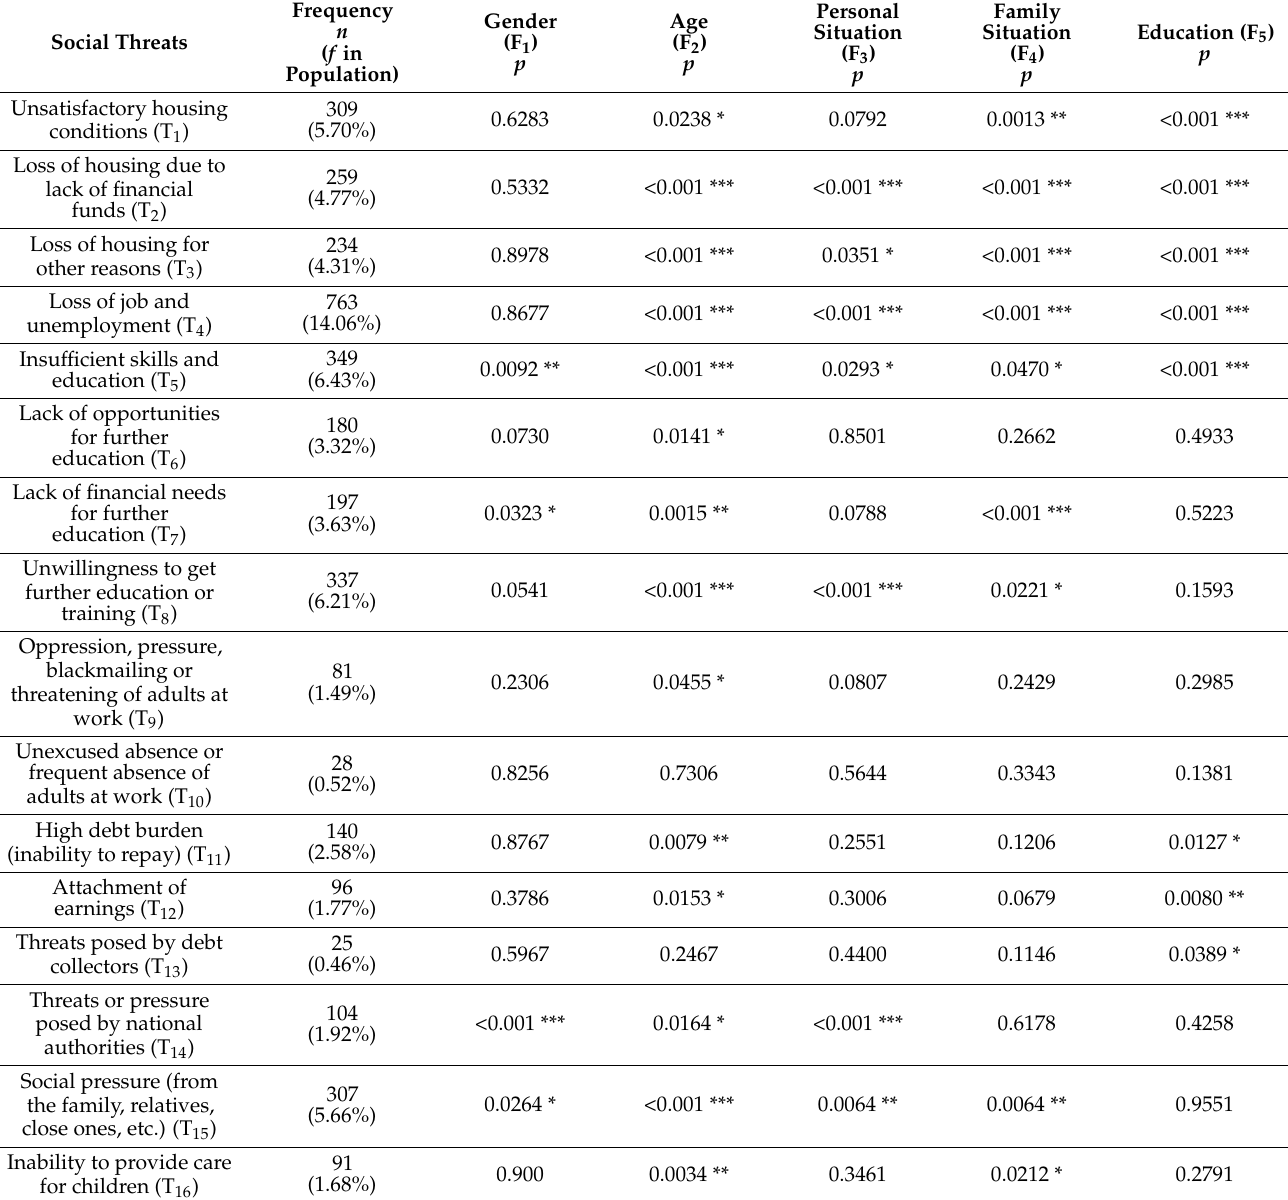
Table 1. Table of the dependences of social threats on gender, age, personal situation, family situation, and education of the respondents (statistical dependencies HF 1 T 1 –HF 5 T 16